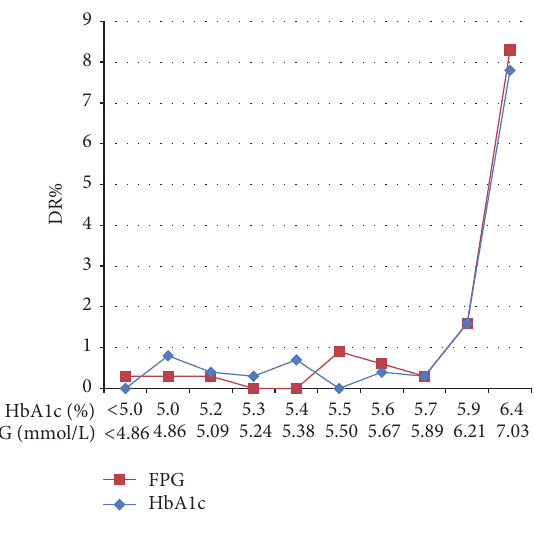
Figure 3: Prevalence of diabetic retinopathy (DR) according to the deciles of distribution of fasting plasma glucose (FPG) and glycated hemoglobin A1c (HbA1c) in the total 3124 subjects. The 𝑥 -axis indicates the minimum value of each decile group.